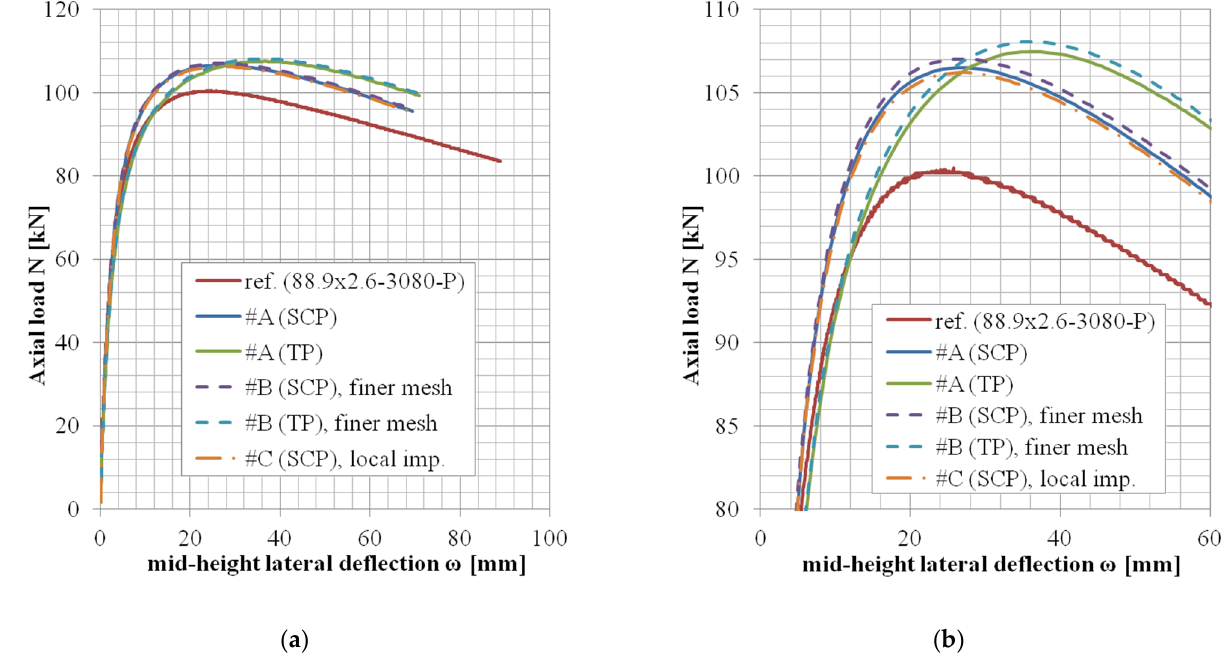
Figure 6. Experimental and FE loads vs. midheight lateral deflection curves of 88.9 × 2.6-3080-P [38]: ( a ) whole; ( b ) zoomed. The differences in the matter of the force-deflection curves between modeling ap- proaches #A, #B, and #C (shell numerical model with default mesh size, finer mesh size, and local imperfection, respectively) are depicted for selected specimens of the cross-sec- tional set 88.9 × 2.6 in Figures 4–6.